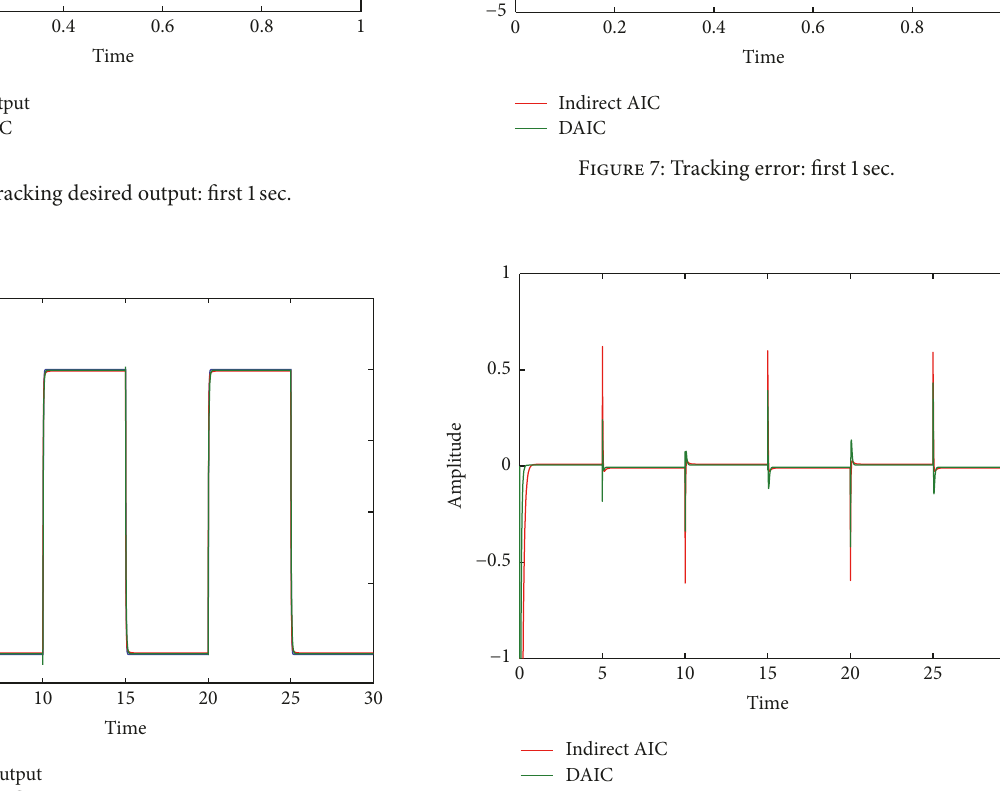
Figure 8: Tracking error: amplitude − 1 ∼